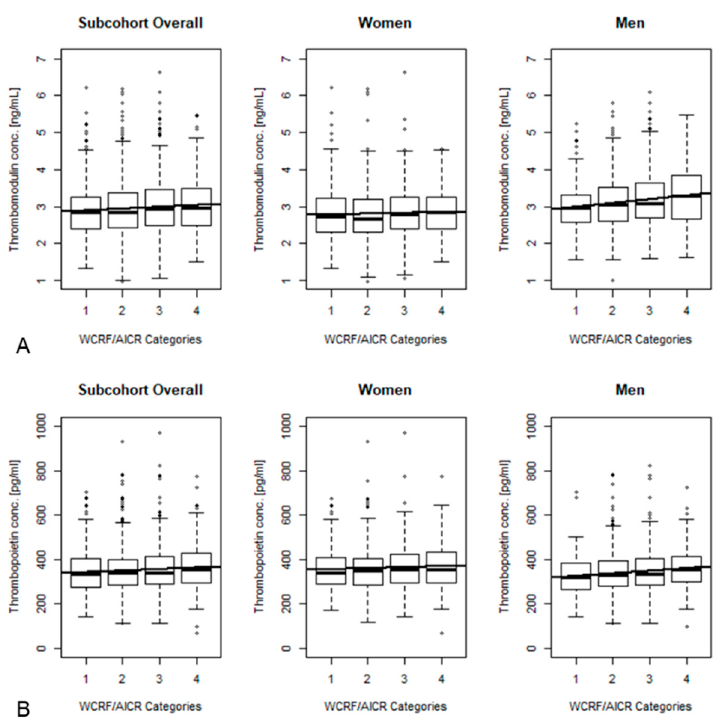
Figure 1. Thrombomodulin ( A ) and thrombopoietin ( B ) concentrations across WCRF/AICR score categories ( n = 2276, 1196 women and 1071 men).